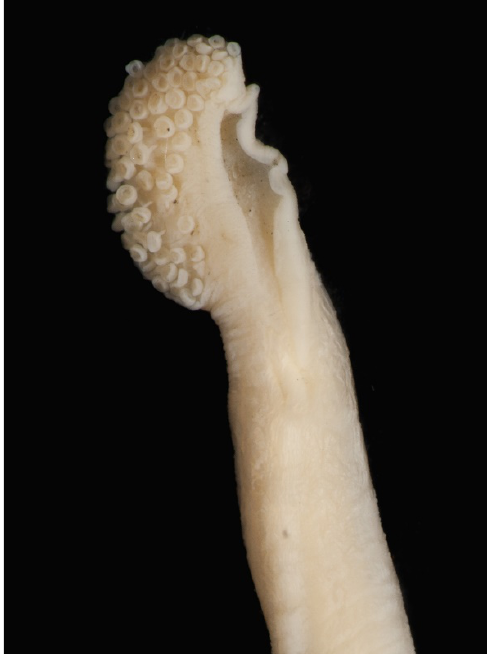
Figure A3. Tentacular club of the holotype of Sepia typica (Steenstrup, 1875) (NHMD-77360, female ML 26, 6gm, Zoological Museum, Copenhagen).